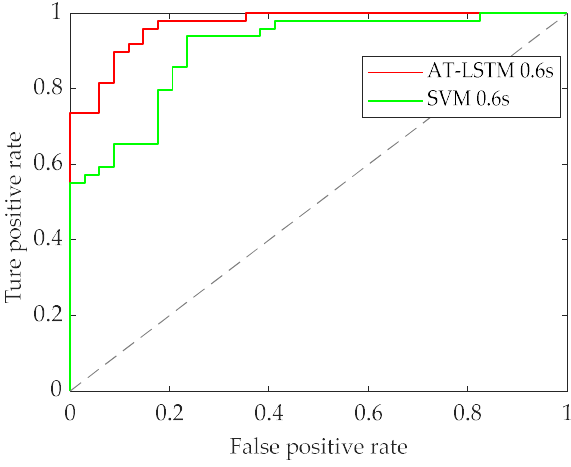
Figure 13. ROC curve of model identification 0.6 s in advance.